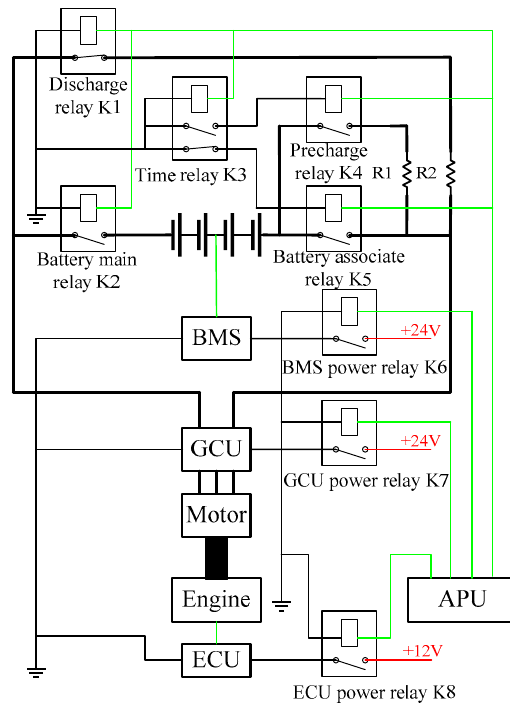
Figure 7. The system circuit.